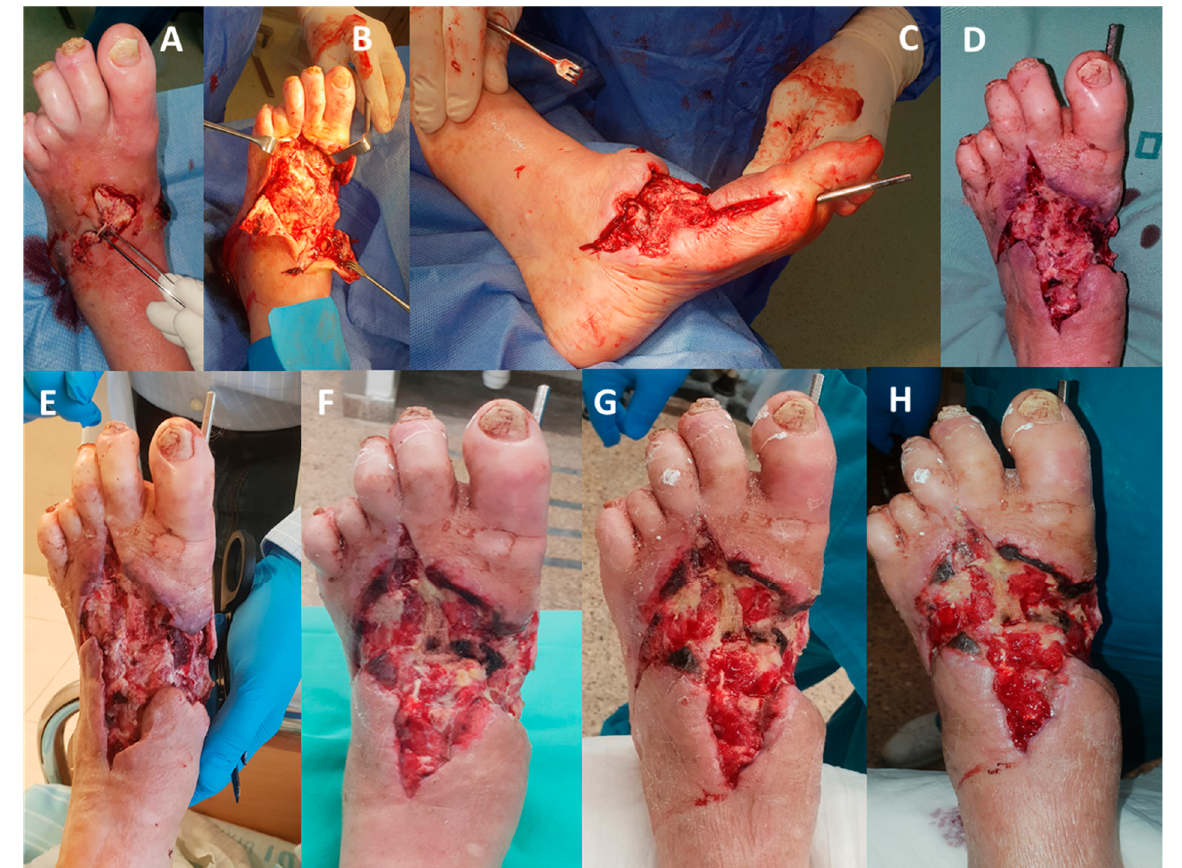
Figure 12. Impressive granulation despite lack of dorsal foot artery (Case Report 10). ( A ) Patient with sepsis and bacteremia due to necrotizing fasciitis, with diabetic midfoot deformity due to Charcot neuroarthropathy. ( B ) Patient underwent deep debridement to the bone. ( C , D ) The foot was stabilized with 5 mm Steinman Pin Beaming the medial column. ( D ) Following the operation, the wound was treated with chlorine-based solution (Milton solution) twice a day for four days. ( E ) One day after the operation the foot was viable with minor marginal skin necrosis. ( F ) Four days after the operation, the patients started to be treated with COD. ( G ) Three days after COD treatment, increase granulation is noted. ( H ) Ten days after COD treatment, extensive granulation is noted.